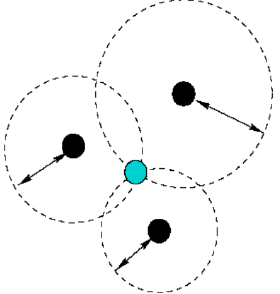
Figure 6. Trilateration technique.